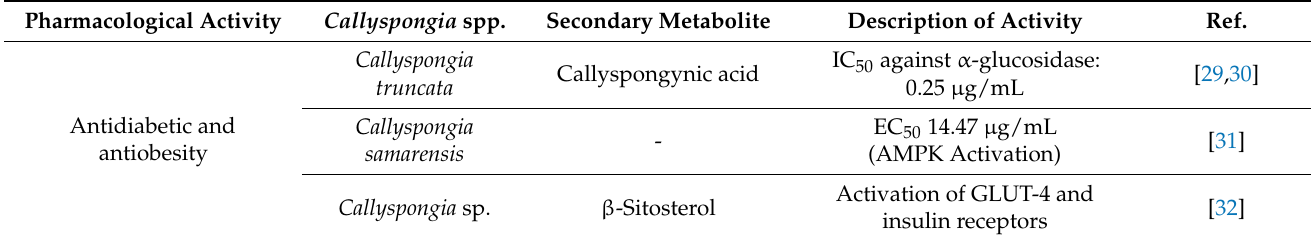
Table 1. Pharmacological activities of Callyspongia